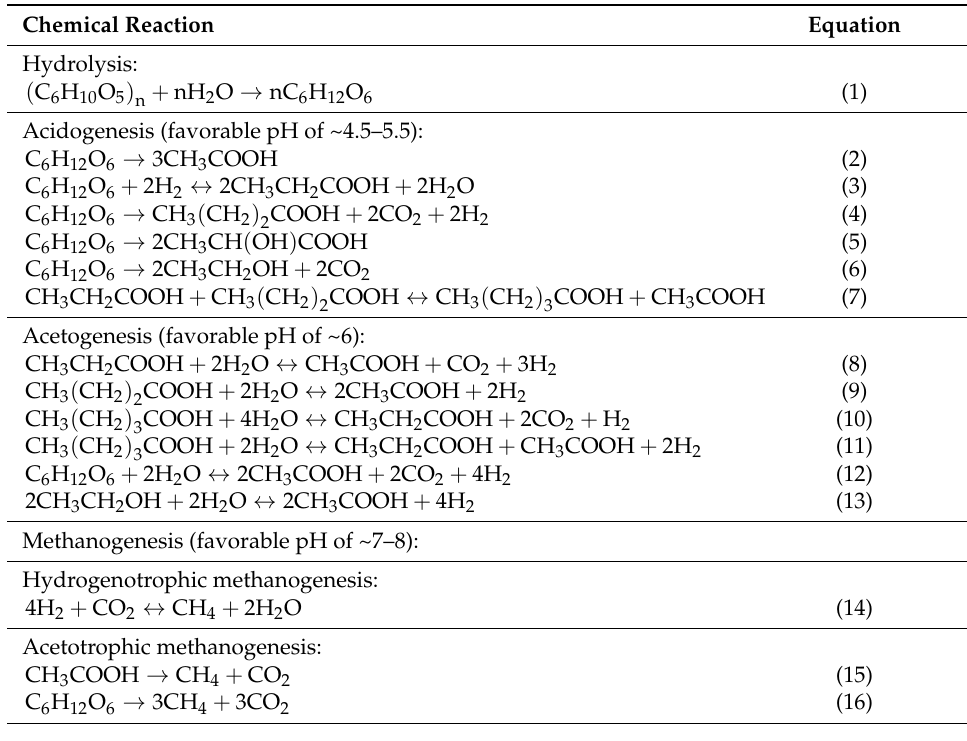
Table 1. Biochemical pathways of the anaerobic digestion of polysaccharides for methane (CH 4 ) production by different groups of microorganisms